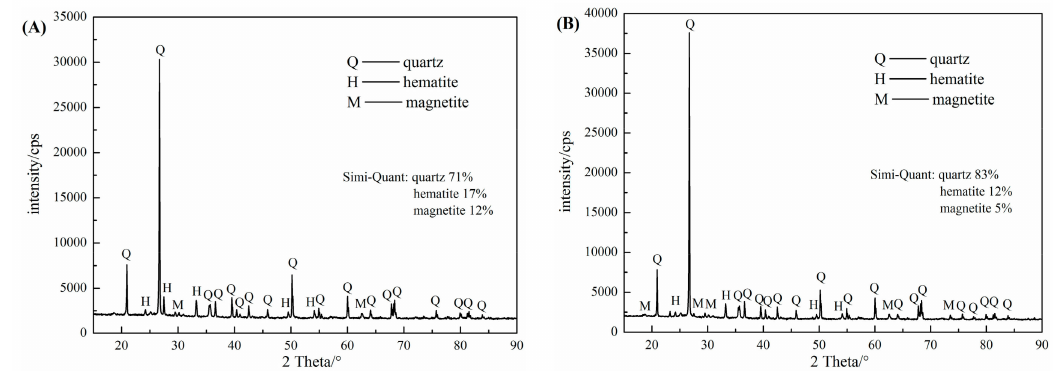
Figure 9. X-ray diffraction of flotation tailings with collector SFA ( A ) or collector UFA ( B ).